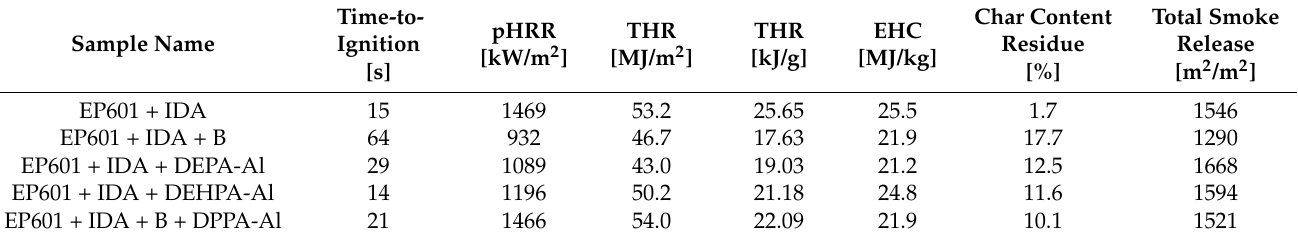
Table 7. Results from cone